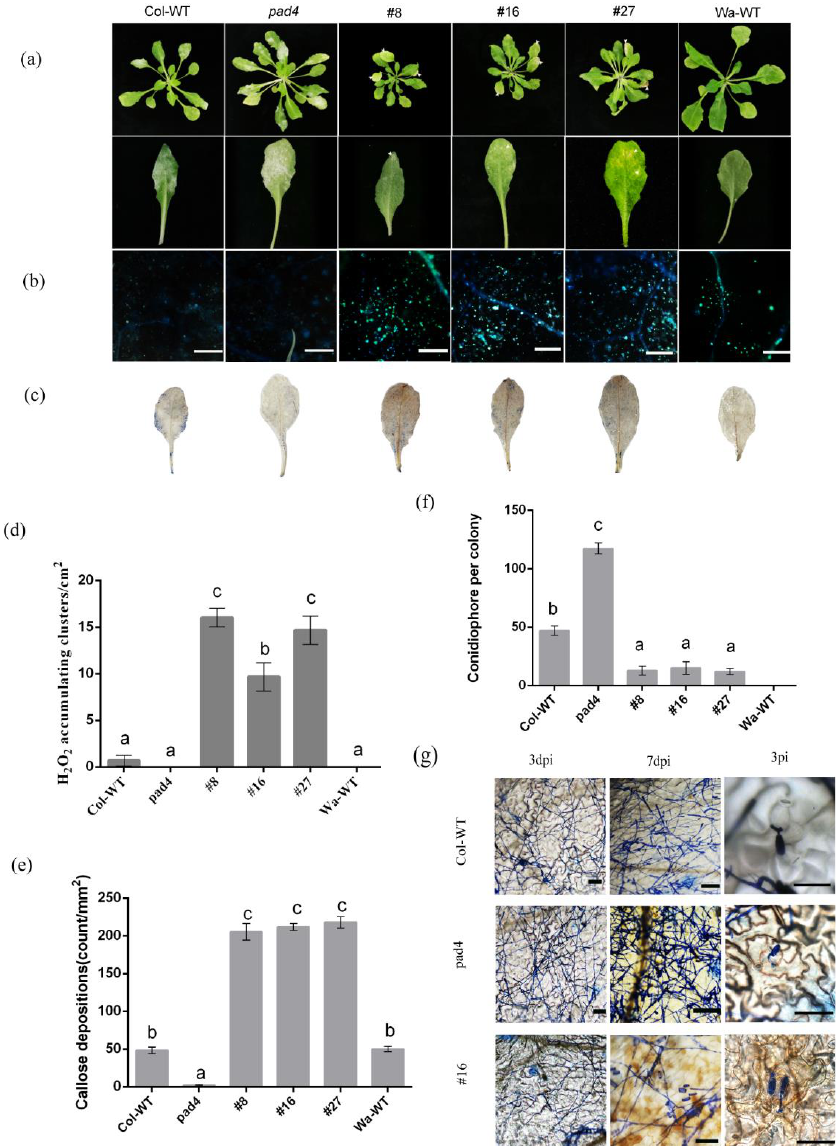
Figure 5. Overexpression of HbRPW8-a prevent powdery mildew colonization. ( a ) Over-expressing lines (#8, #16, #27), pad4 mutant, Col-WT and Wa-WT plants were infected with powdery mildew. Col-WT, as a control, leaves were covered with hyphae; pad4 , as a sensitive line, leaves were covered layer of hyphae; The over-expression line leaves covered a few hyphae; Wa-WT, as a disease resistant plant, with almost no hyphae on leaves. Plants were photographed 7 dpi. Plant cell death induced by E. cichoracearum colonies was highlighted by the arrow; ( b ) The content of callose depositions in the leaves of over-expression lines was the highest, followed by Wa-WT, Col-WT, and pad4 . Callose deposition were stained with DAB at 48 hpi, and observed under microscope UV light; scale bar = 100 µ m. ( c ) A large number of reactive oxygen species accumulation clusters appeared in the leaves of overexpression lines, accompanied by densely cell death; Col-WT leaves showed a few reactive oxygen species accumulation clusters and cell death; pad 4 and Wa WT showed slight cell necrosis. The accumulation of ROS and cell death in different plants at 3 dpi. ROS was visualized with DAB. Plant cell death were stained with trypan blue; ( d ) representation of DAB-positive stained clusters in over-expressing lines, pad4 , Col-WT and Wa-WT leaves of per cm 2 . Data were shown as the means ± SD from three independent experiments and columns with different letters